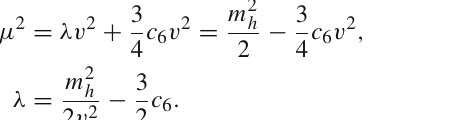
Fig. 1 The two kind of instabilities triggered by a sizable c 6 . Left: A negative c 6 is responsible for a large-field-value instability close to the scale (cid:2) . Right: The EW minimum is generated by the physics at the